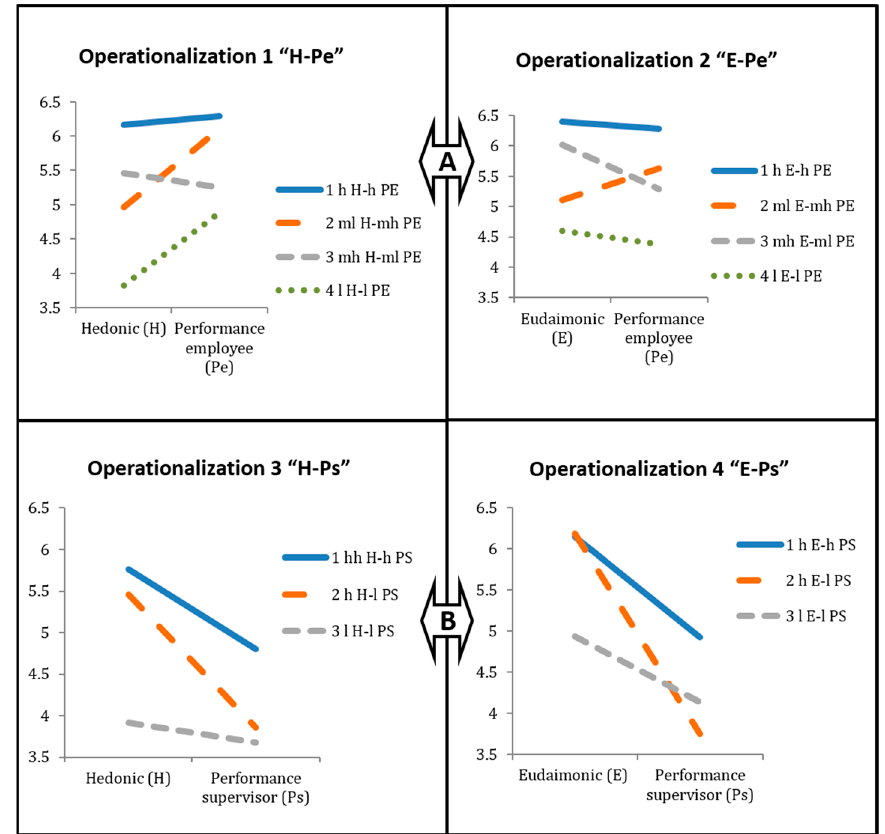
Figure 1. Four cluster analyses of different combinations of well-being dimensions and performance from two sources. h stands for high level; mH stands for medium high level; ml stands for medium low level; l stands for low level. H-Pe stands for Hedonic-Performance (self-rated by the Employee); E-Pe stands for Eudaimonic-Performance (self-rated by the Employee); H-Ps stands for Hedonic-Performance (evaluated by the Supervisor); E-Ps stands for Eudaimonic-Performance (evaluated by the Supervisor); A and B inside the arrows denote different types of comparisons that can be made among the different operationalizations of well-being and performance within the “happy-productive” worker framework.